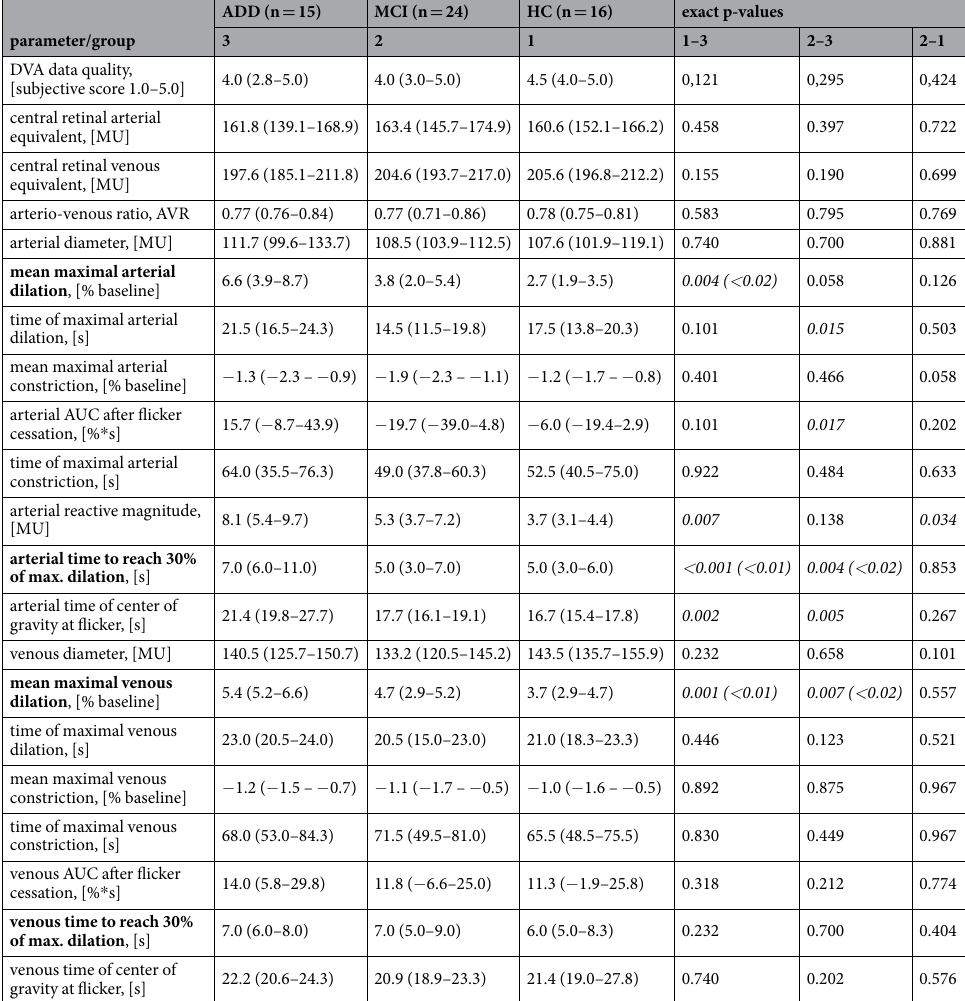
Table 3. Values of parameters of static retinal vessel analysis and retinal vessel reaction to flickering light. Legend to Table 3: median (1 st quartile – 3 rd quartile), significance with Mann-Whitney-U-test. Exact p-values reported without correction for multiple comparisons. P-values < 0.05 are accentuated with italic. Parameters of the primary analysis are accentuated bold. For these parameters significant p-values after manual correction for multiple comparisons are shown in brackets. ADD: Alzheimer’s disease dementia group; HC: cognitively healthy controls; MCI: mild cognitive